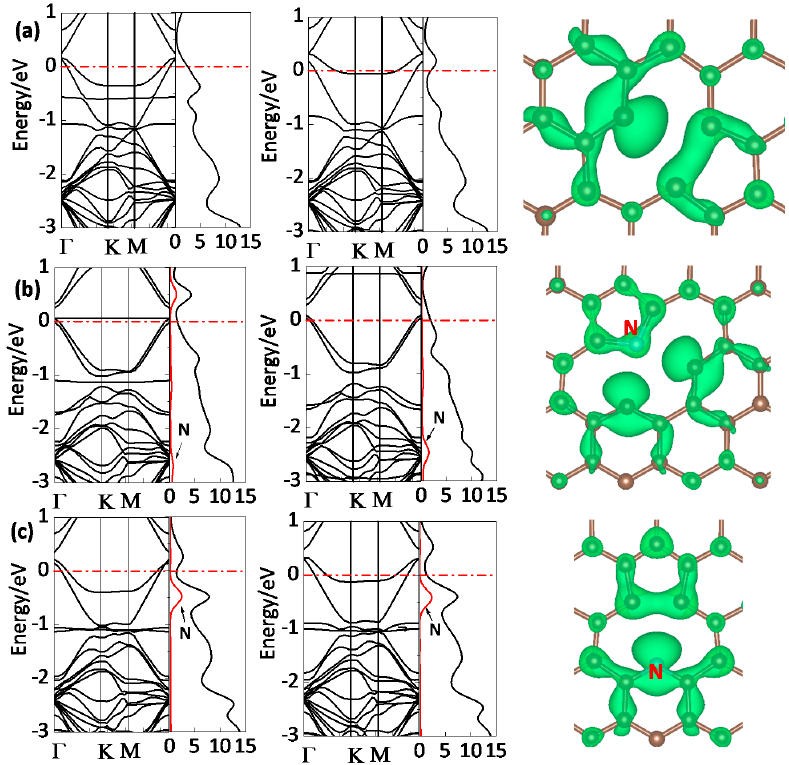
Figure 7. Band structure, density of states (DOS) and band-decomposed charge density (BDCD) iso-surces (0.006 e/Bohr 3 ) of ( a ) D1 defected graphene; ( b ) pyrrolic and ( c ) pyridine N doping graphene.